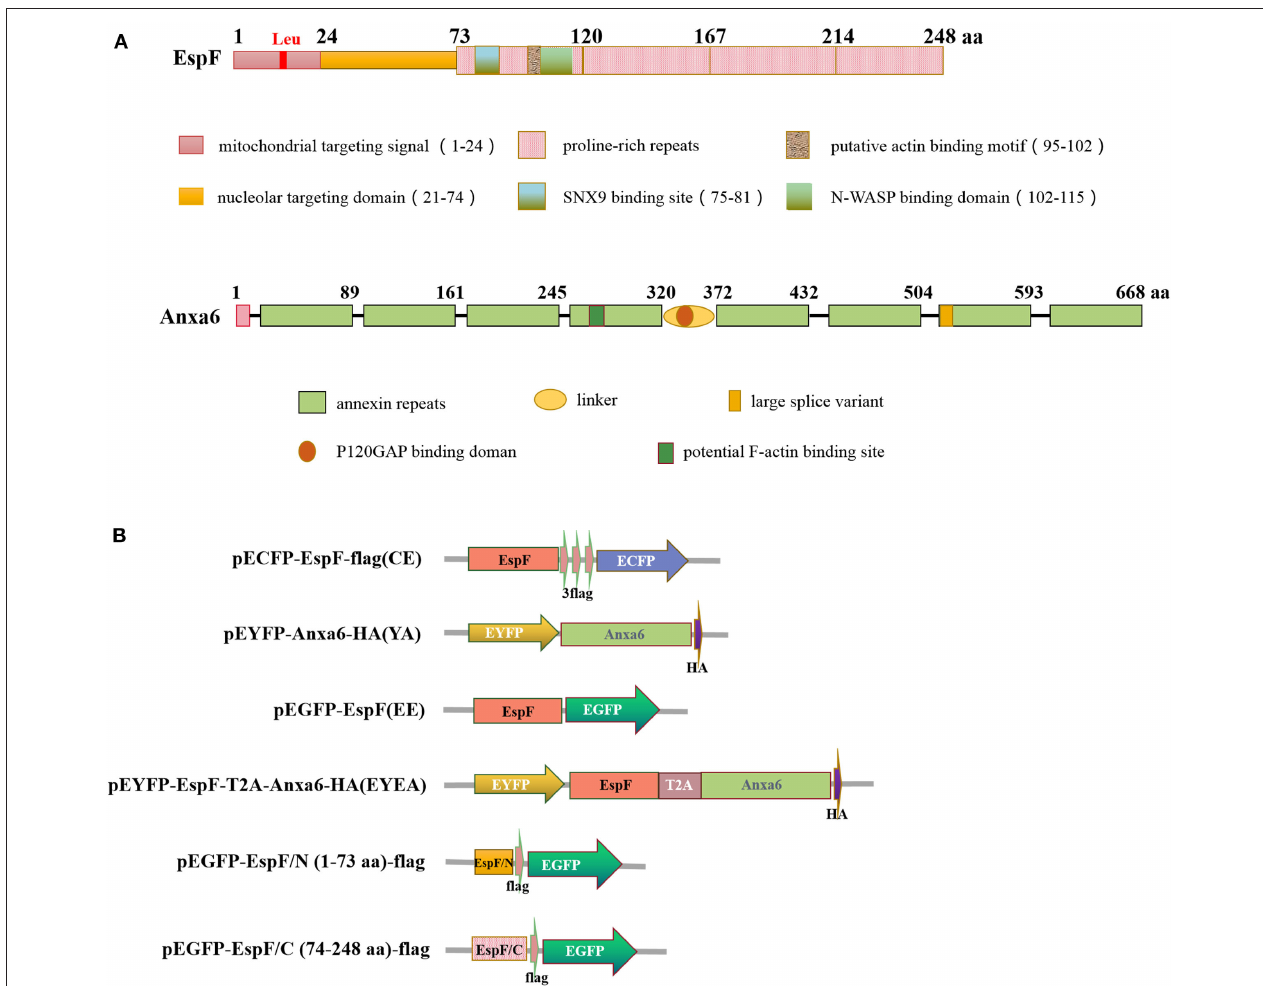
FIGURE 1 | Diagram of EspF protein and ANXA6 protein structure (A) and plasmid constructs used in this study (B) . aa, Amino acid.